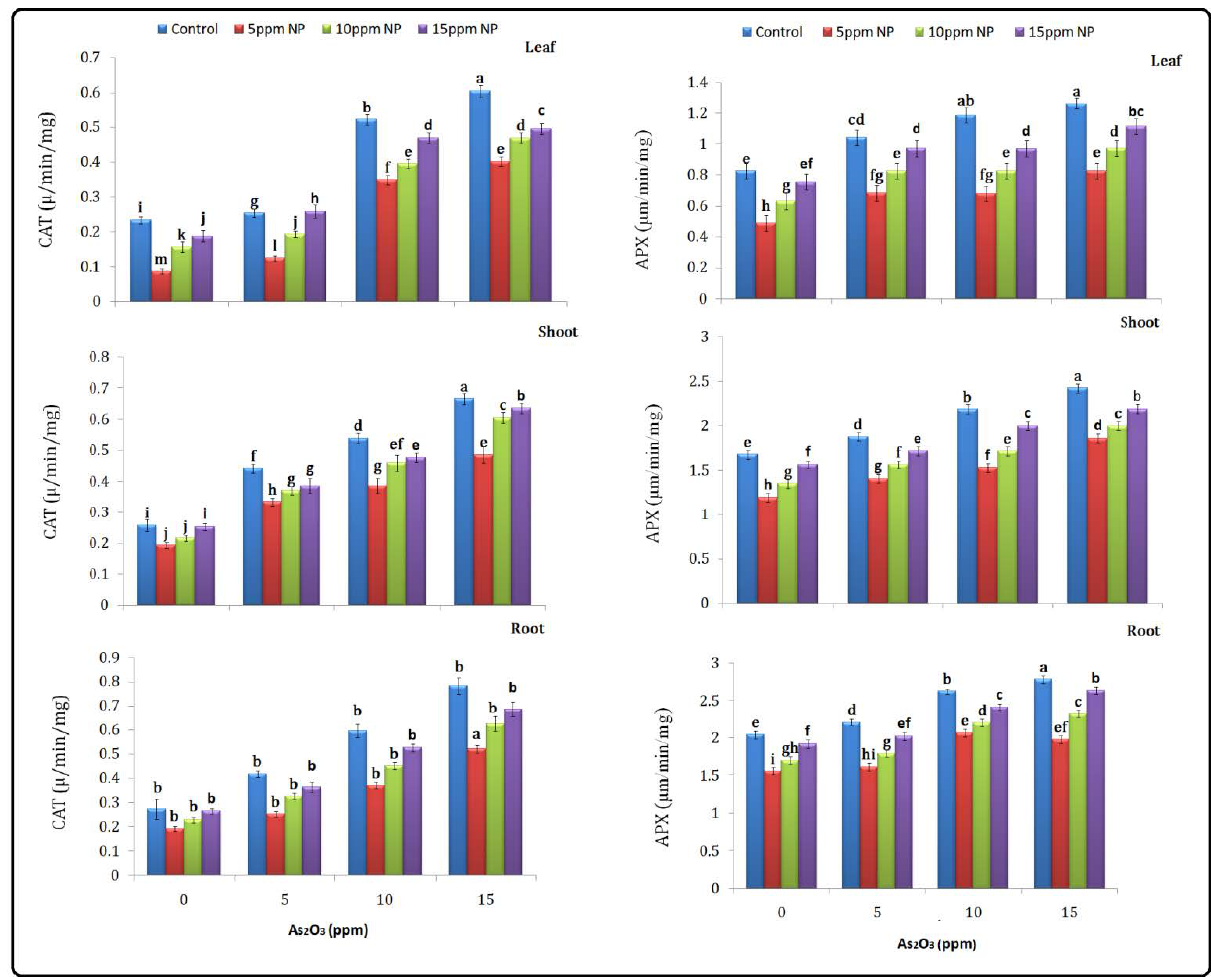
Figure 4. Effect of Bacillus subtilis synthesized iron oxide nanoparticles on SOD and POD content of rice ( Oryza sativa L.) in arsenic-contaminated water. Different letters indicate significant differences ( p < 0.05) between treatments.